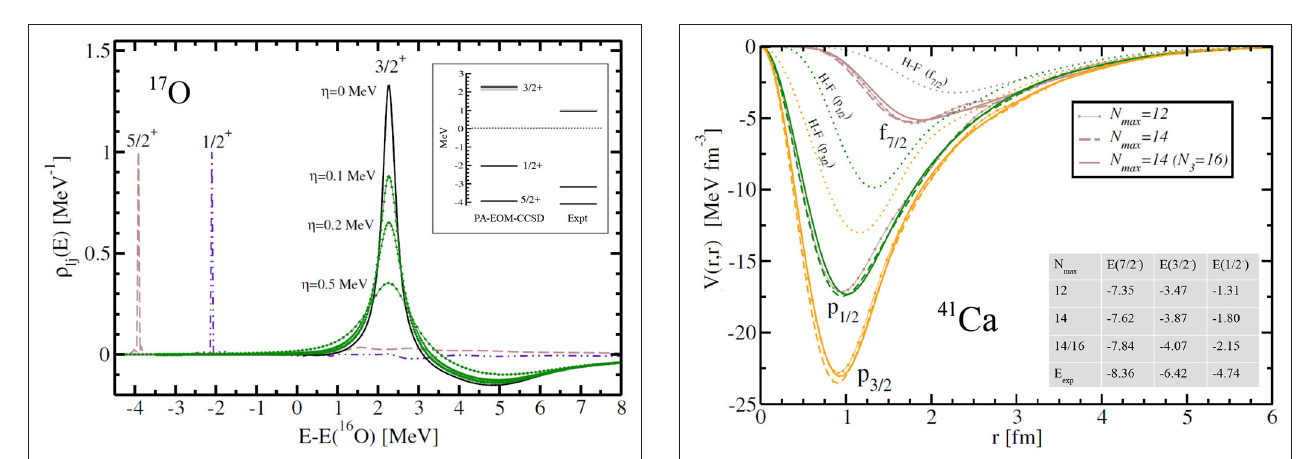
FIGURE 1 | Computed level densities in 17 O. For the J π = 3 / 2 + level density, results are shown for several values of the parameter η to illustrate the smooth convergence pattern for η → 0. The inset shows the energies of the ground state, first excited and 3 / 2 + resonant states in 17 O calculated at the PA-EOM-CCSD truncation level (see text for details).